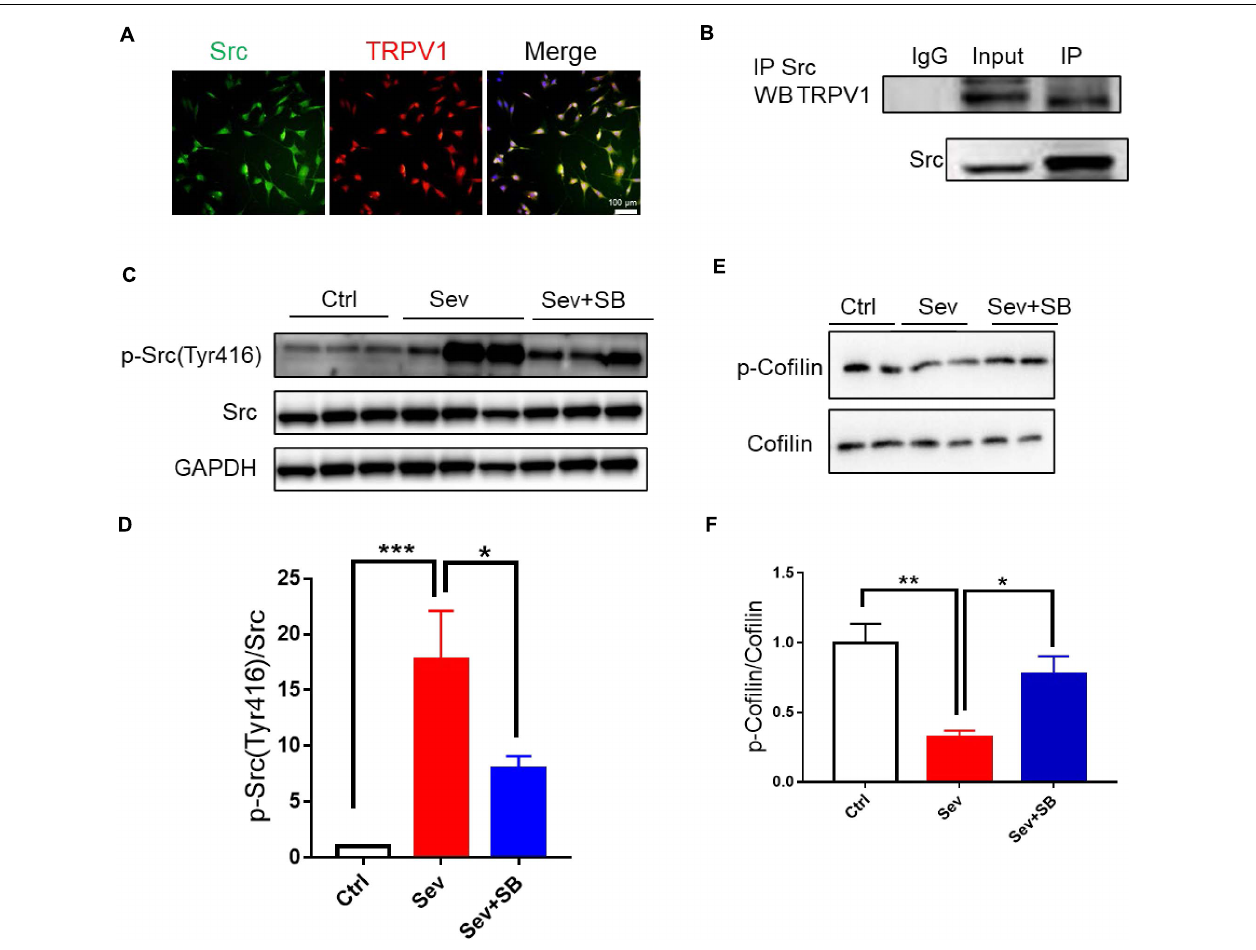
FIGURE 7 | TRPV1 binds to Src and suppresses inhibition of cofilin. (A) Representative image of TRPV1 (red) and Src (green) fluorescence in HT22 cell line. (B) Co-immunoprecipitation of Src and TRPV1 using anti-Src antibody in hippocampal protein extracts from control mice. (C,D) Representative image (C) and relative expression of (D) Src phosphorylation at tyrosine 416 (p-Src) after with or without SB 366791 (500 µ g/kg) treatment [ n = 6/group, one-way ANOVA, F ( 2 , 15 ) = 10.4, p = 0.0015]. (E) Representative Western blot bands. (F) Quantitative analysis of (E) [5 mice per group, one-way ANOVA, F ( 2 , 12 ) = 9.3, p = 0.0036]. Data are presented as the mean ± SEM. ANOVA followed by Bonferroni post hoc test. * p < 0.05; ** p < 0.01; *** p < 0.001. Ctrl, control; Sev, sevoflurane; SB, SB